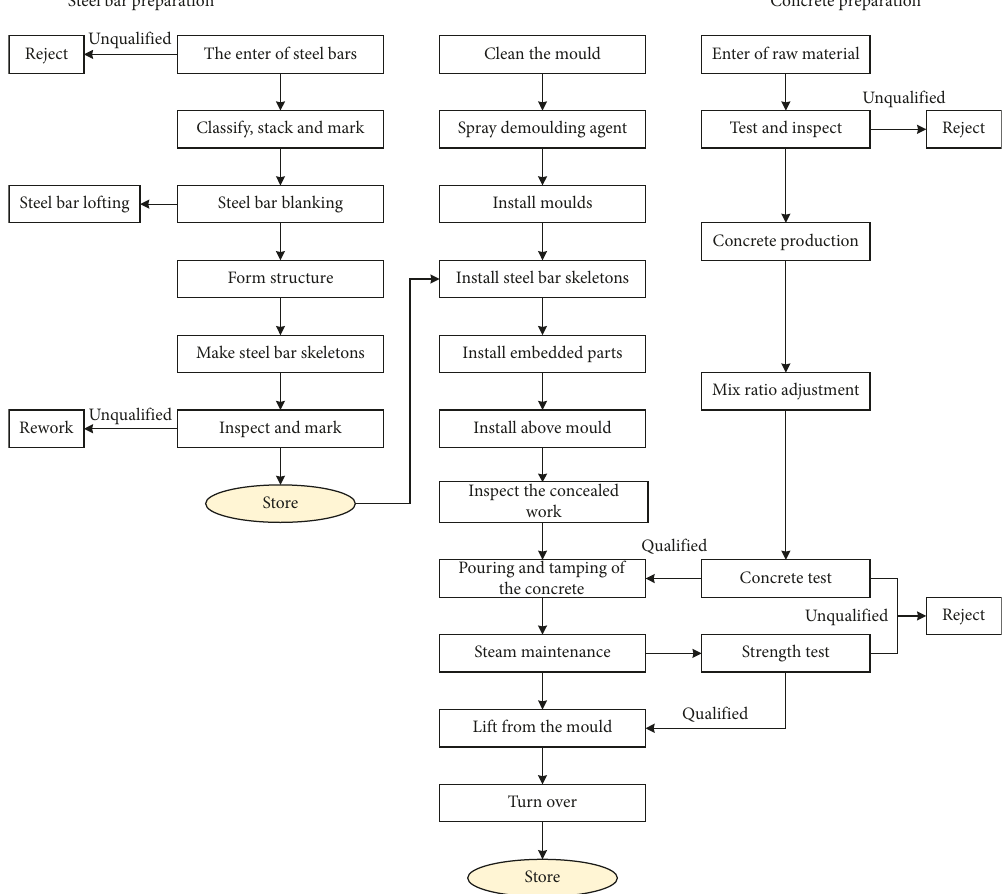
Figure 7: Processing flows to produce prefabricated